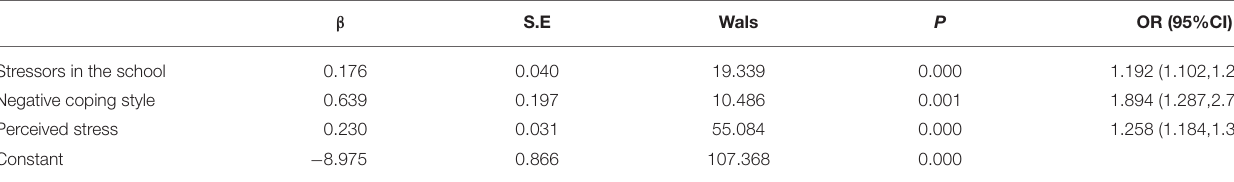
TABLE 4 | Stepwise multiple logistic regression analysis on results of anxiety symptoms ( n =